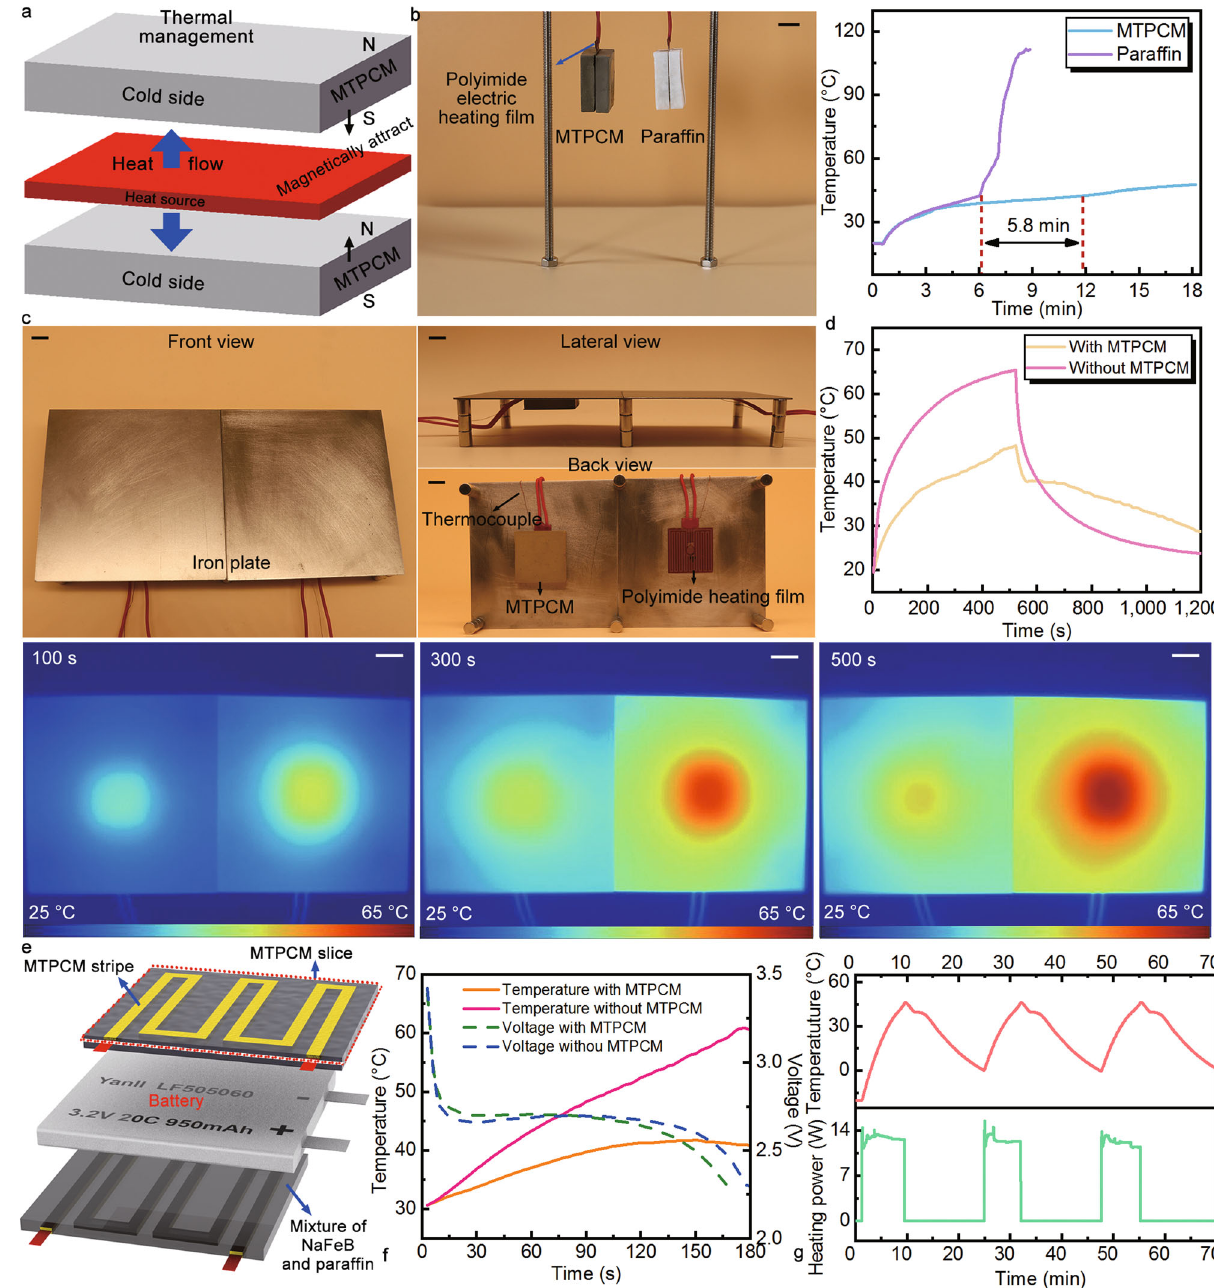
Fig. 6 Thermal management applications of magnetically tightened form-stable phase change materials (MTPCMs). a Schematic diagram of MTPCM blocks applied to the temperature control of a nonmagnetic heat source. b The corresponding photo and temperature evolution of MTPCM and paraf fi n blocks. Scale bar: 10 mm. c Photos about the temperature control of MTPCM on the magnetic heat source. Scale bars: 1 cm. d Temperature evolution and the corresponding thermal infrared images of the heat source with and without the MTPCM. Scale bars: 5 mm. e Schematic illustration of battery thermal management system. f Temperature and voltage evolution of lithium-ion battery during the discharging process. g Temperature variation of the battery and the heating power of one MTPCM slice under the low-temperature protection fl uctuated dramatically over a short period. But for the fi lm using Fig. 6c, polyimide electric heating fi lms stuck to the iron plates acting as the heat source. In virtue of the magnetism from the MTPCM block for thermal management, its temperature changed iron plates, the MTPCM block could directly contact the fi lm for steadily and held at about 40 °C for 43 s and 73 s in the heating temperature control, and as a comparison, the other fi lm did not and cooling section, respectively. This difference in temperature take any active heat dissipation steps. When the heating started, change for the two heating fi lms can also be discovered intuitively the temperature of the fi lm without MTPCM rose rapidly by the sequential thermal infrared pictures. The aforesaid two reaching 65.33 °C in 522 s under a power of 6 W, and once the experiments prove that MTPCMs have superb thermal manage- power was cut off, its temperature dropped quickly to its initial ment capacity and this arises from the combination of their good value (Fig. 6d). Overall, the temperature of the heat source thermal properties and magnetism.